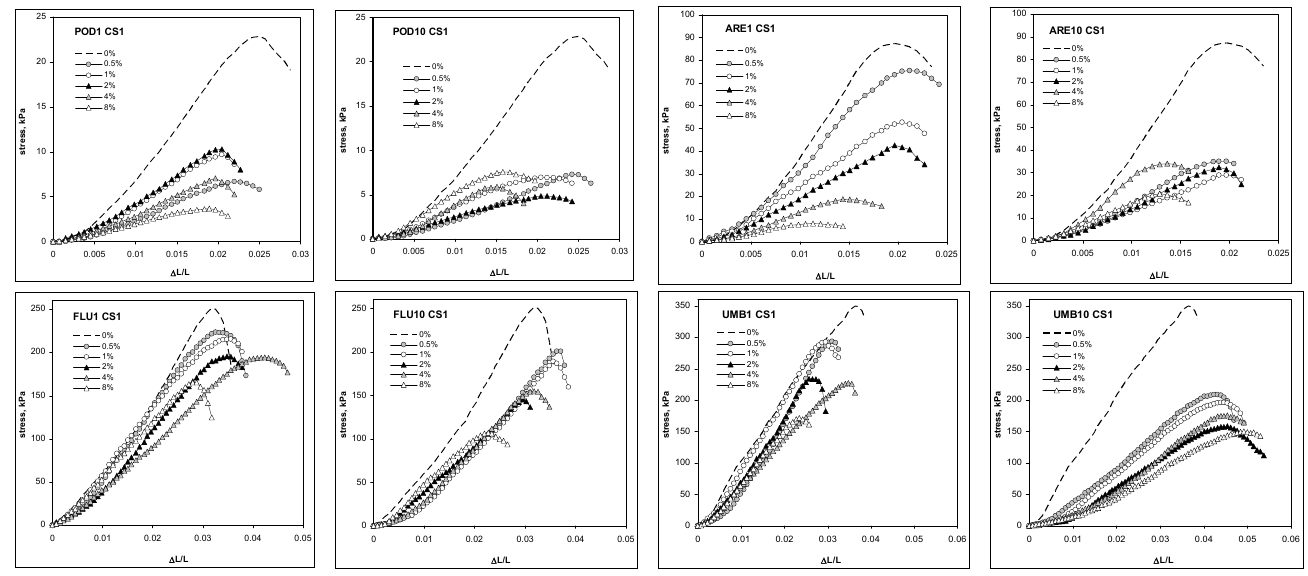
Figure 1. Exemplary compression stress-dilatation dependence for the aggregates of Podzol (POD), Fluvisol (FLU), Umbrisol (UMB) and Arenosol (ARE) amended with different amounts of chitosan CS1, preconditioned with 1 or 10 cycles of wetting–drying. The number of the cycles is written after the abbreviation of each soil.